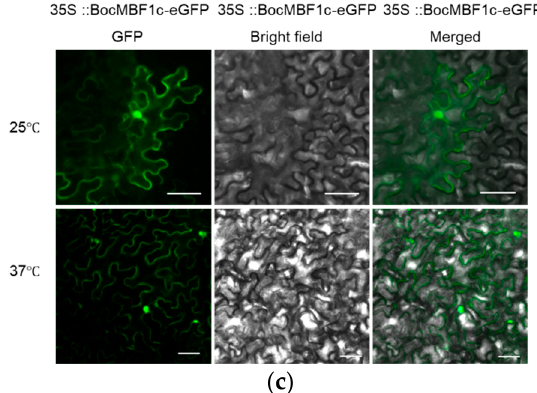
Figure 6. Heat stress led to the nucleus localization of the BocMBF1c protein. ( a ) Schematics of the constructs for 35s:: eGFP and 35s:: BocMBF1c - eGFP (pBE- BocMBF1c - eGFP ). ( b ) The GFP protein alone has no obvious localization preference either under normal temperature or high temperature in N. benthamiana leaf tissue. ( c ) BocMBF1c translocated to the nucleus when exposed to 37 °C for 1 h. Scale bar, 50 μ m.